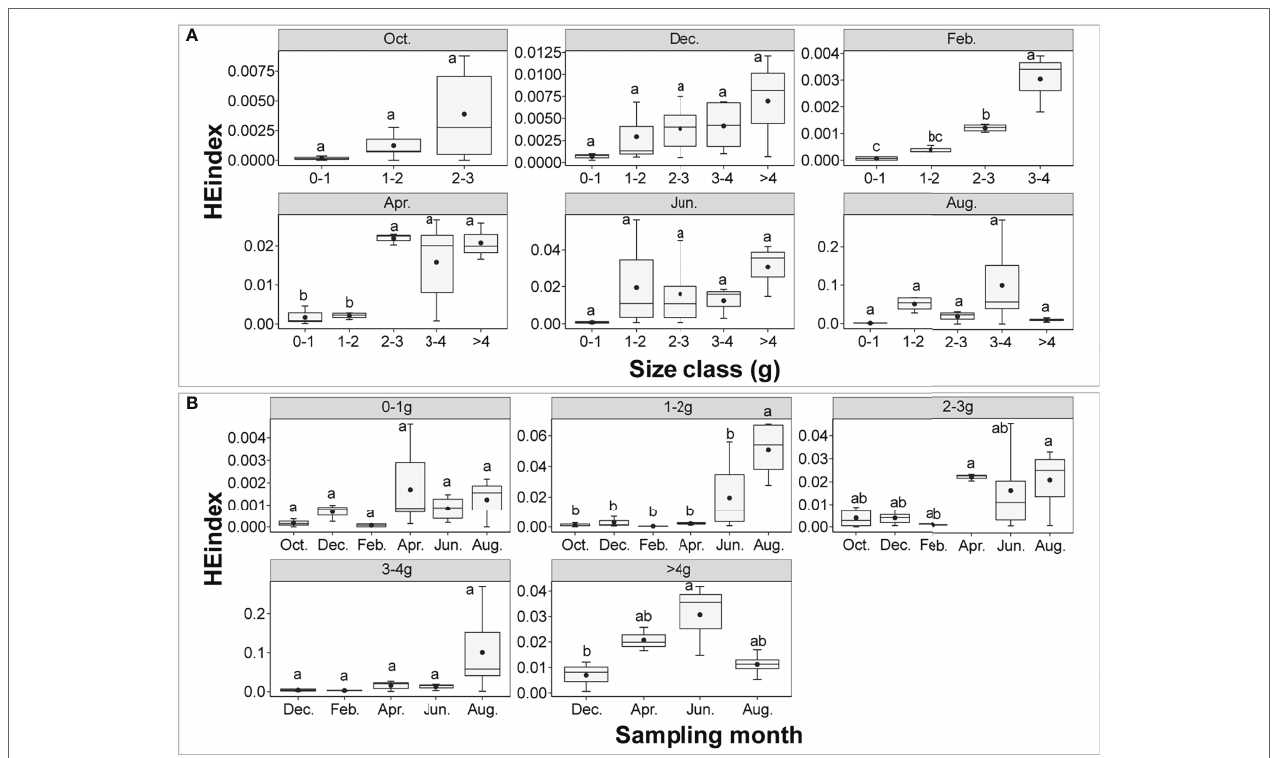
FIGURE 6 | The P. aibuhitensis burrow HEindex for different size classes (A) and sampling months (B) . The black dots in the center of each box chart represent the mean values. Different lowercase letters represent significant differences between different treatments (P <